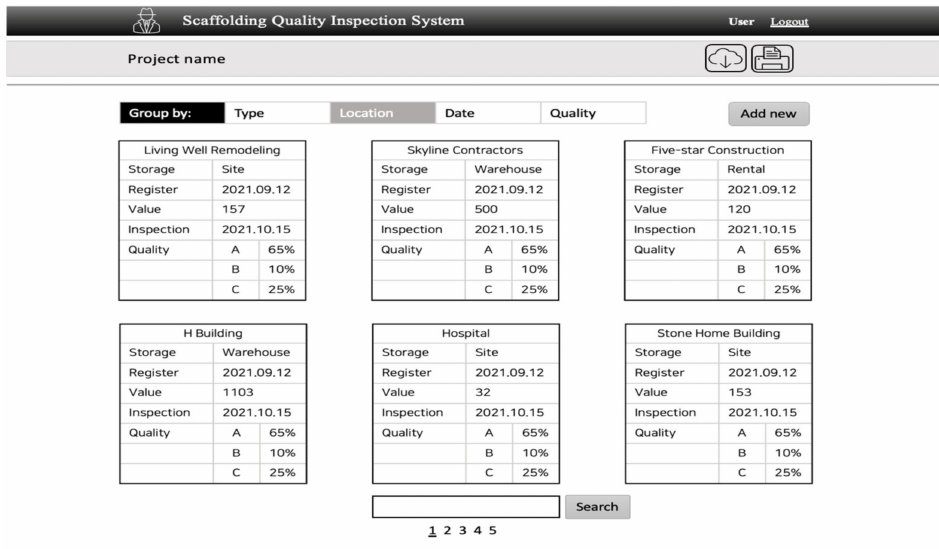
Figure 20. Prototype of graphical user